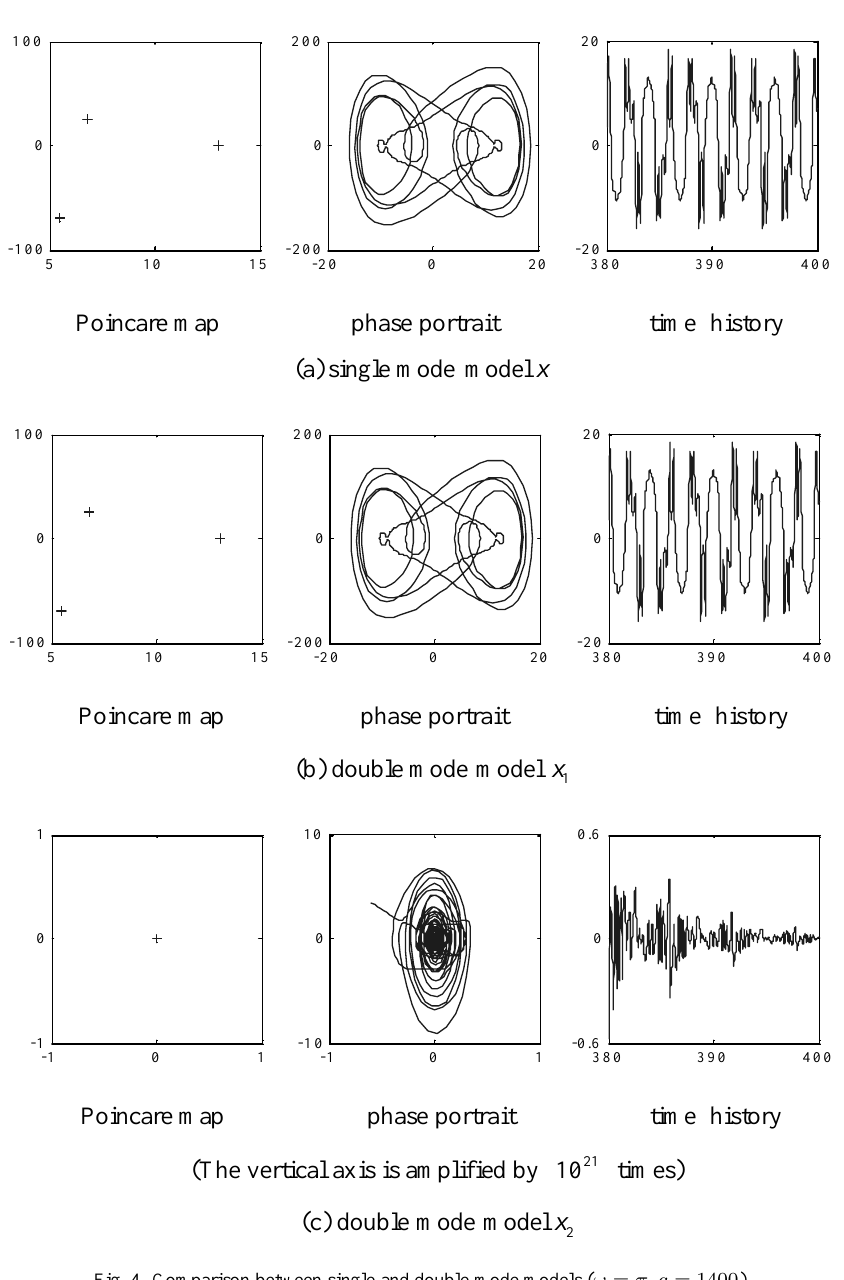
Fig. 4. Comparison between single and double mode models ( ω = π,g = 1400